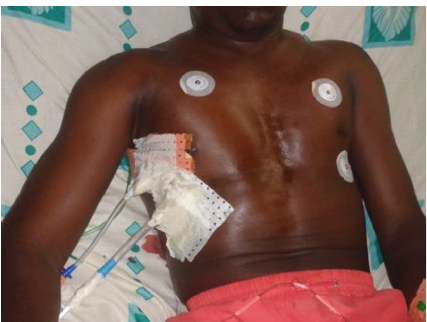
Figure 3: Picture showing the patient with massive subcutaneous emphysema despite 2 chest tubes inserted.